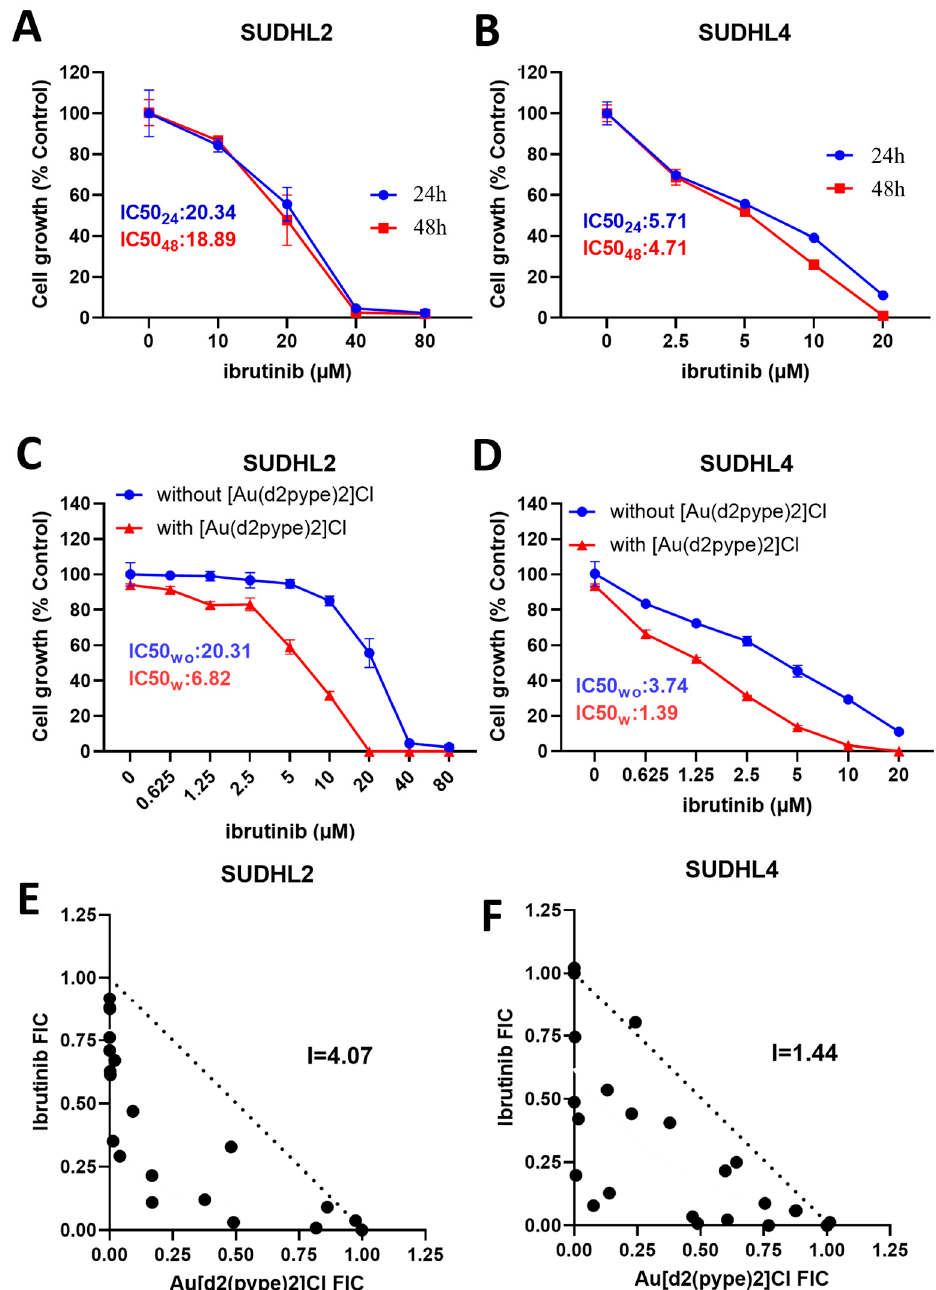
Figure 4. The cell proliferation and the isobologram analysis in DLBCL cell lines treated with ibrutinib with or without [Au(d2pype) 2 ]Cl. SUDHL2 ( A ) and SUDHL4 ( B ) were treated with indicated concentrations of ibrutinib for 24 or 48 h. ( C ) SUDHL2 and ( D ) SUDHL4 cells were treated with ibrutinib alone or in combination with 0.25 µ M of [Au(d2pype) 2 ]Cl for 24 h. In the figures, the IC 50 of ibrutinib alone is presented as IC 50wo , and the IC 50 of ibrutinib with [Au(d2pype) 2 ]Cl is presented as IC 50w . ( E , F ), isobolograms between [Au(d2pype) 2 ]Cl and ibrutinib in the lymphoma cell lines. The plots showing the FIC values indicate the drug interaction and the dashed lines mark the FIC = 1. Two independent experiments with three technical replicates were performed in each lymphoma cell line.